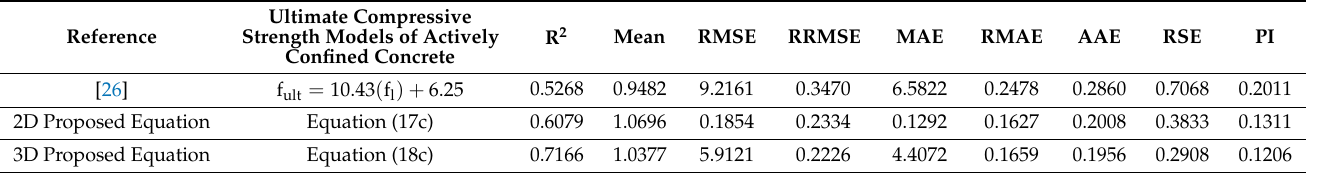
Table 15. Statistical indicators of the ultimate strength models of SMA-confined